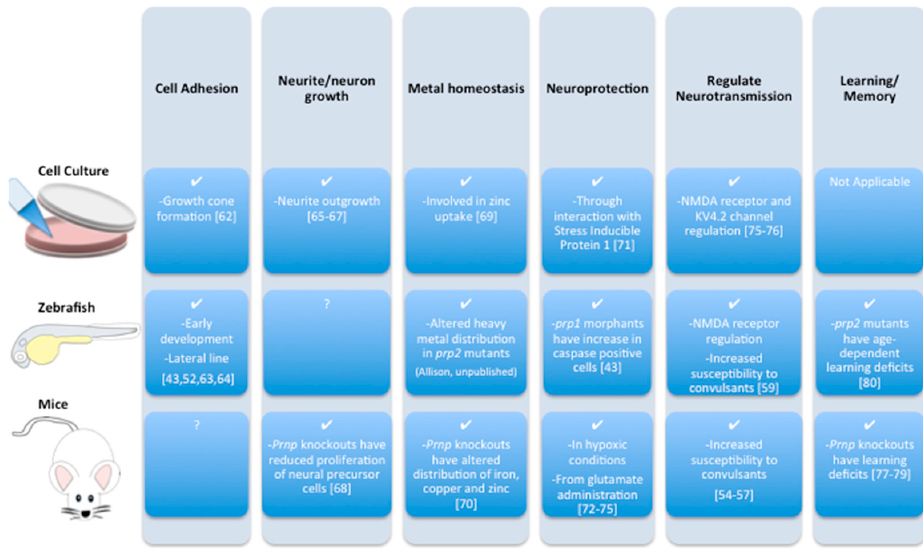
Figure 4. Cellular prion protein (PrP C ) has several functions attributed to it that have been derived from characterizing cells, fish or mice lacking PrP C .